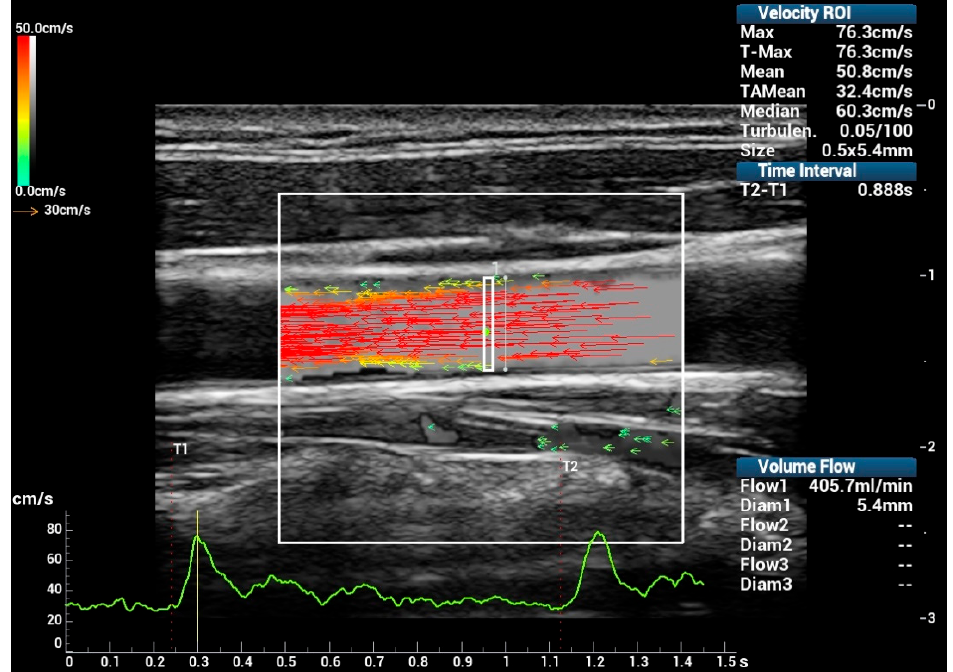
Figure 1. PW measurements: ( a ) big SV covering the vessel for measuring time-averaged mean velocity (TAMEAN) and volume flow (Vol Flow); ( b ) small SV for measuring the maximum velocity (PS).